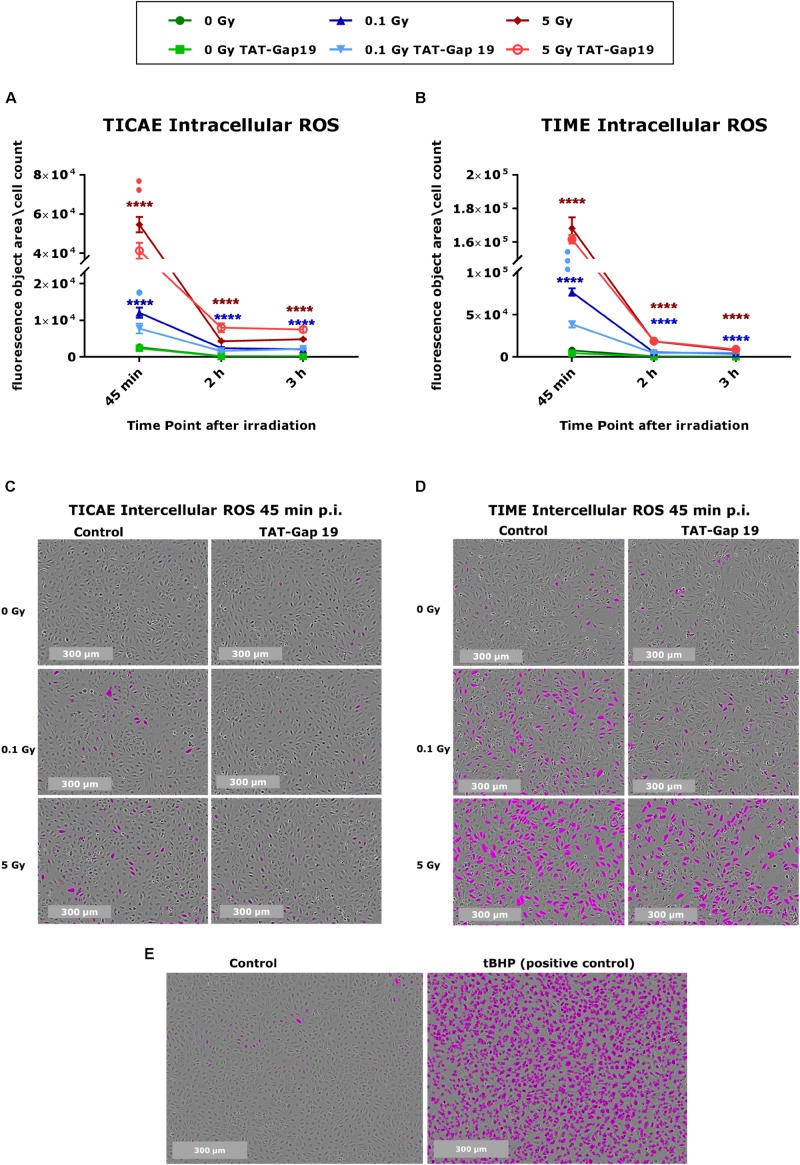
Radiation-induced ROS production and the effect of TAT-Gap19 in TICAE and TIME cells. Intracellular ROS was assessed using CM-H2DCFDA combined with Incucyte live cell imaging at three time points (45 min, 2 and 3 h) after irradiation (A,B). (C,D) Representative images for ROS production at 45 min p.i. in TICAE and TIME cells, with purple colored cells indicating above threshold ROS signal. (E) Representative images for ROS production in TICAE cells in response to tert-Butyl hydroperoxide (tBHP) as a positive control condition; purple colored cells indicate above threshold ROS signal. The values represent the average ± SEM of 8–16 biological replicates for TICAE and TIME cells. Statistical analysis was done with a non-parametric Mann–Whitney T-test. *Indicates statistically significant differences compared to the respective 0 Gy controls. •Indicate statistically significant differences compared to the respective control condition (not treated with TAT-Gap19). */•p < 0.05; **/••p < 0.01; ***/•••p < 0.0001, ****/••••p < 0.00001.